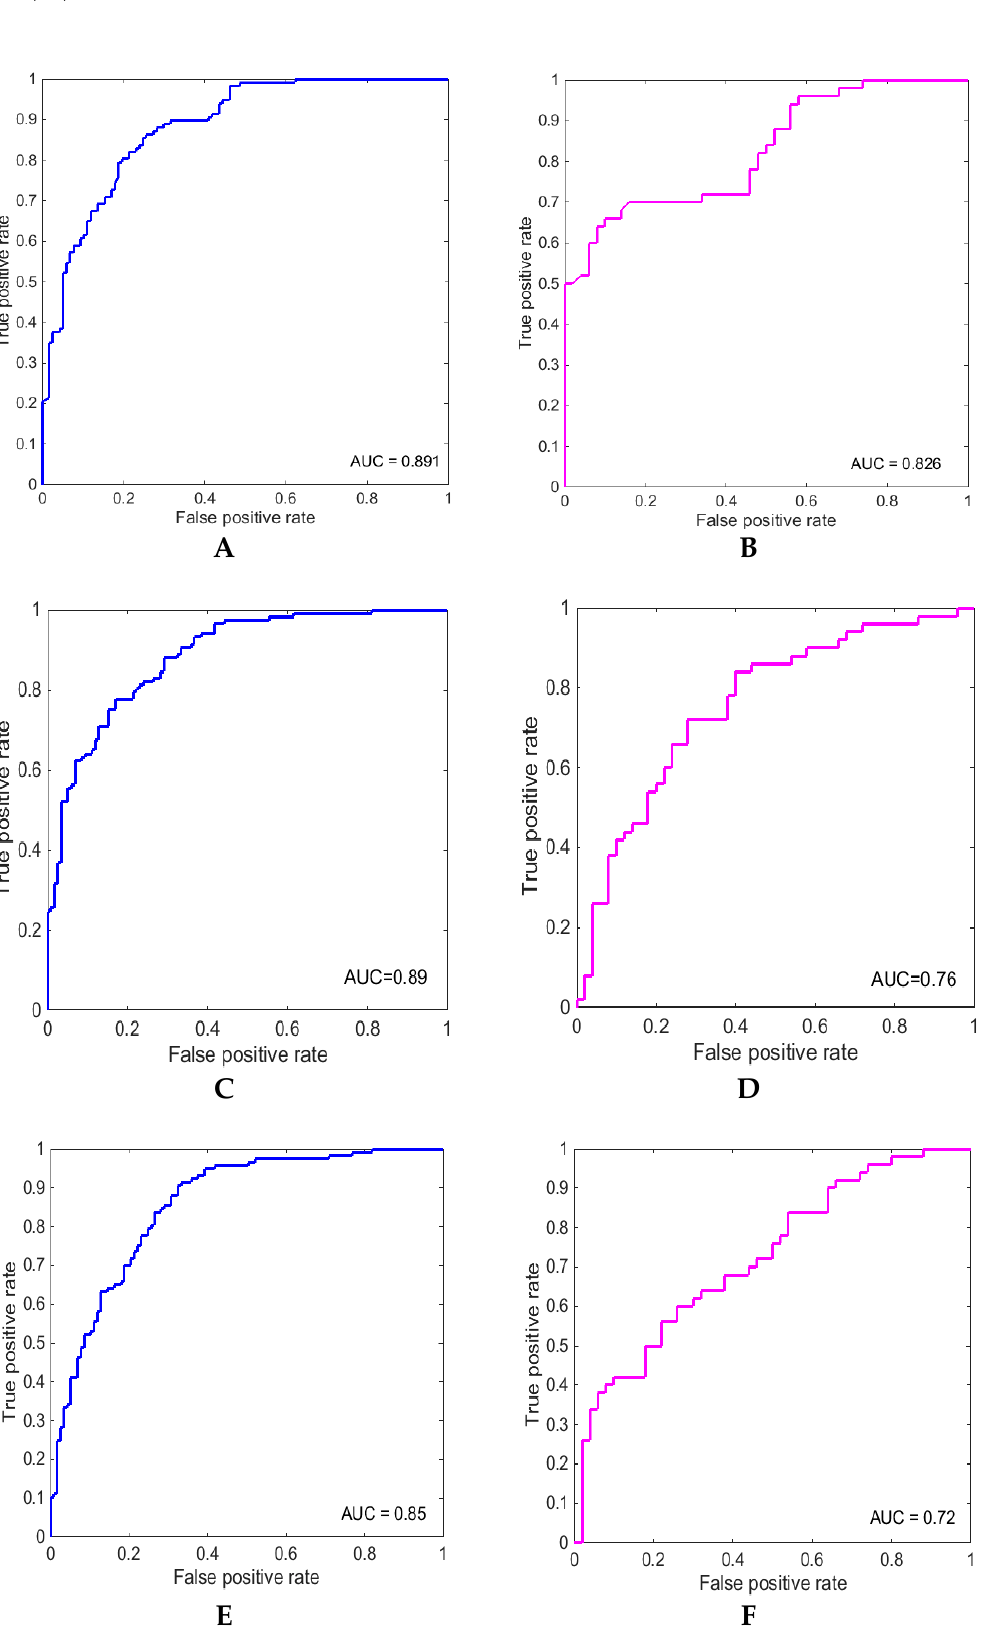
Figure 10. ROC curves and AUC values of: ( A ) RFBFDT with the training dataset, ( B ) RFBFDT with the validating dataset, ( C ) PSOANFIS with the training dataset, ( D ) PSOANFIS with the validating dataset, ( E ) PSOANN with the training dataset, and ( F ) PSOANN with the validating